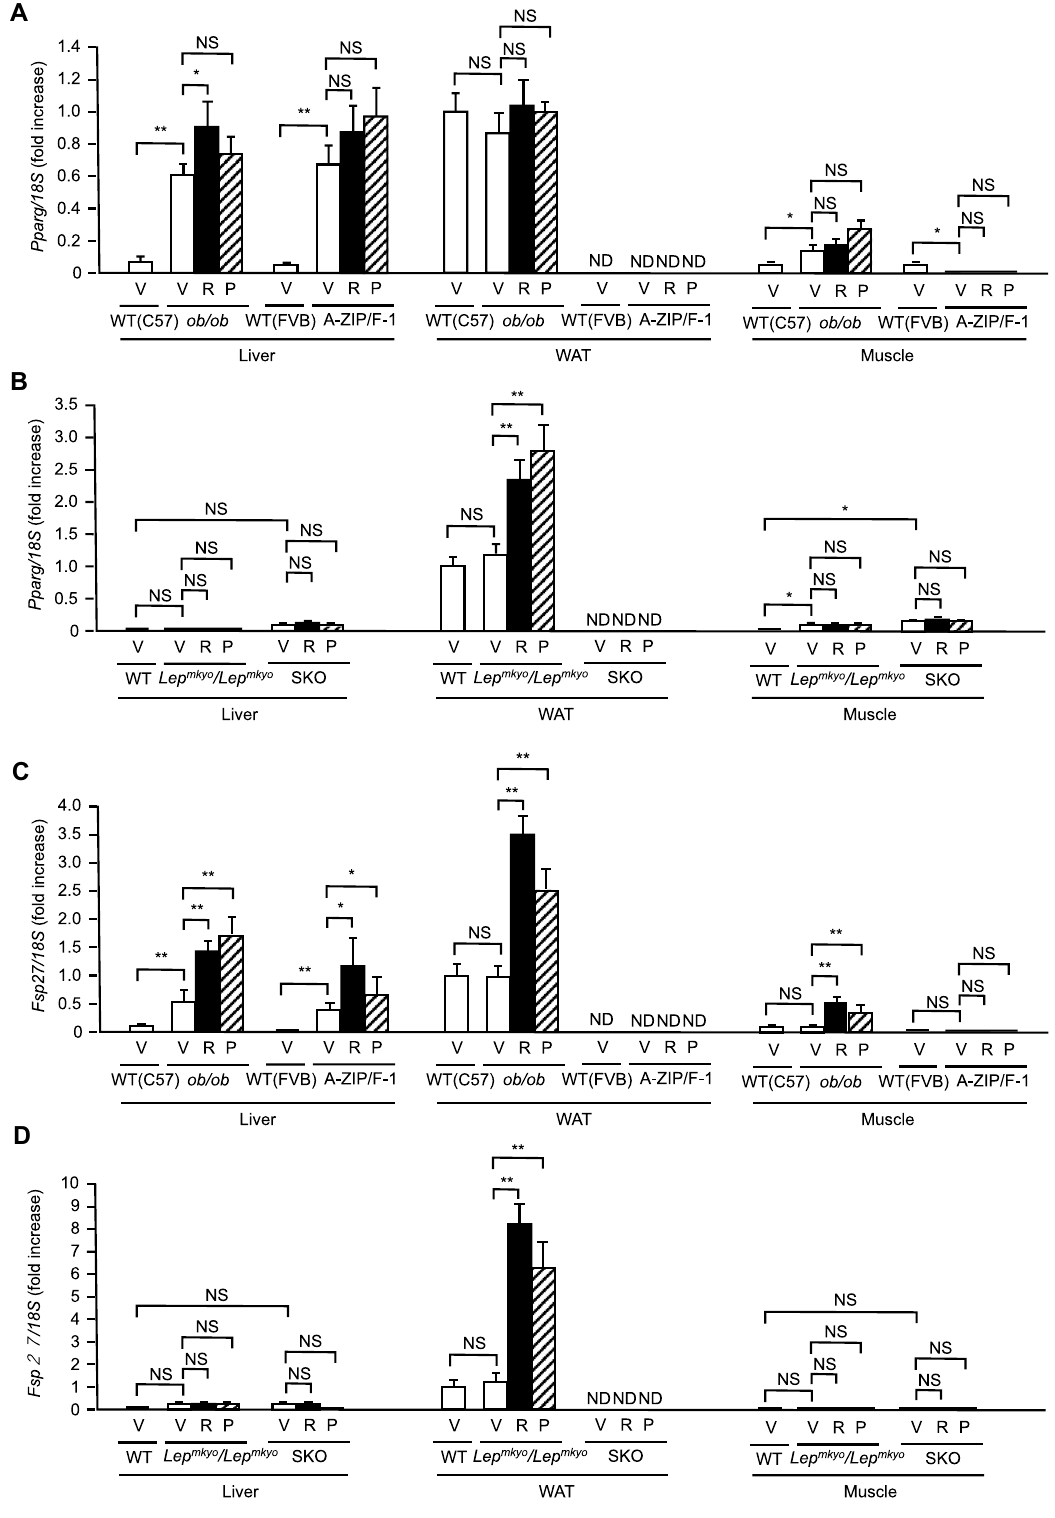
Figure 6. Effect of TZD treatment on Pparg and Fsp27 mRNA expressions in the liver, WAT and skeletal muscle in mouse and rat models of leptin deficient obesity and generalized lipodystrophy. ( A , B ) Pparg mRNA expressions in the liver, WAT and skeletal muscle in C57B/6J WT, ob/ob , FVB/N WT and A-ZIP/F-1 mice ( A ) and F344 WT, Lep mkyo /Lep mkyo and SKO rats ( B ) treated with vehicle, RGZ or PGZ. ( C , D ) Fsp27 mRNA expressions in the liver, WAT and skeletal muscle in C57B/6 J WT, ob/ob , FVB/N WT and A-ZIP/F-1 mice ( C ) and F344 WT, Lep mkyo /Lep mkyo and SKO rats ( D ) treated with vehicle, RGZ or PGZ. mRNA expression levels were normalized by 18S. Values are means ± SEM ( n = 10 per group). ND, not determined. * P < 0.05, ** P < 0.01, NS, not significant (one-way ANOVA followed by Tukey’s